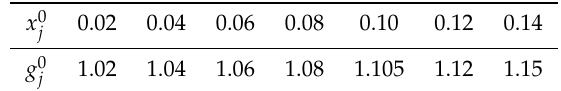
Table 2. Positive data set of values.